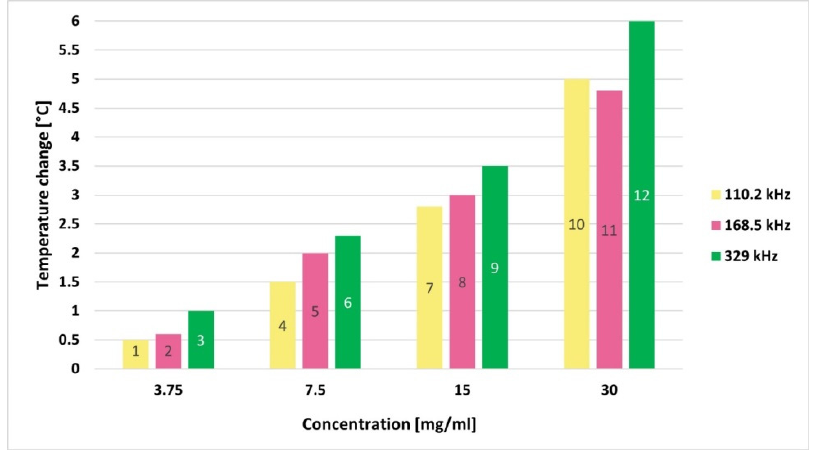
Figure 7. Bar chart of all measurements.